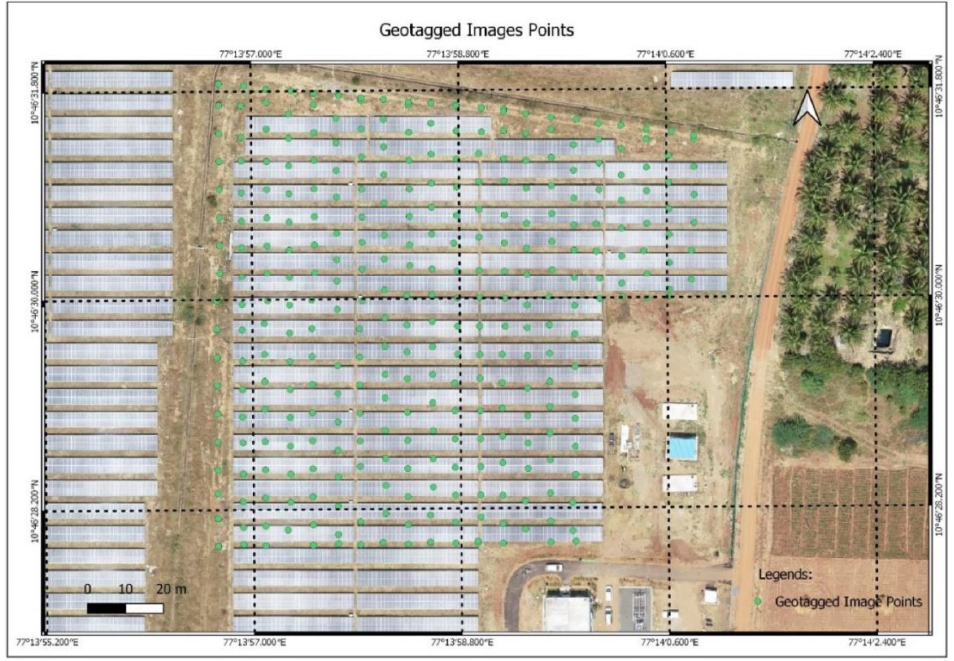
Figure 5. Geotagged image photo